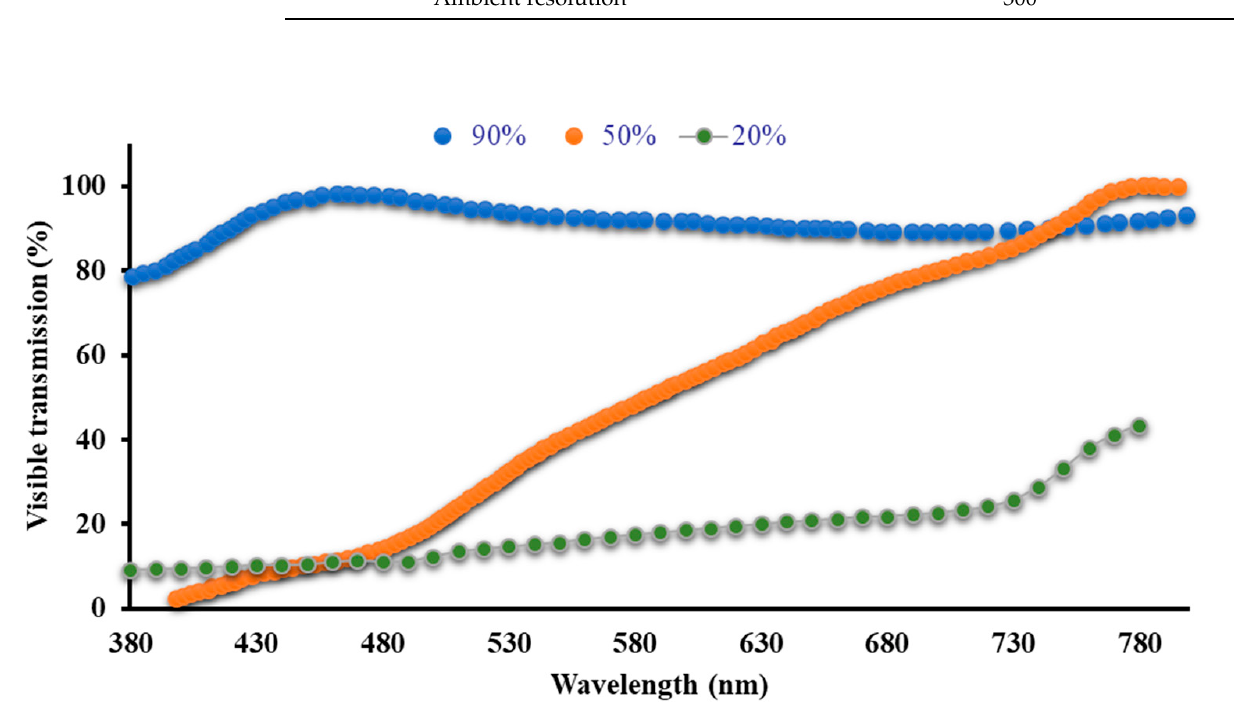
Figure 3. Wavelength dependent visible transmission for 20% [47], 50% [48] and 90% [49] semi-transparent Perovskite cell for BIPV window. 20%, 50% and 90% Graphs are reproduced from [47–49] respectively. Reprint with permission [47], 2021, Elsevier and [48,49]; 2021, John Wiley and Sons.